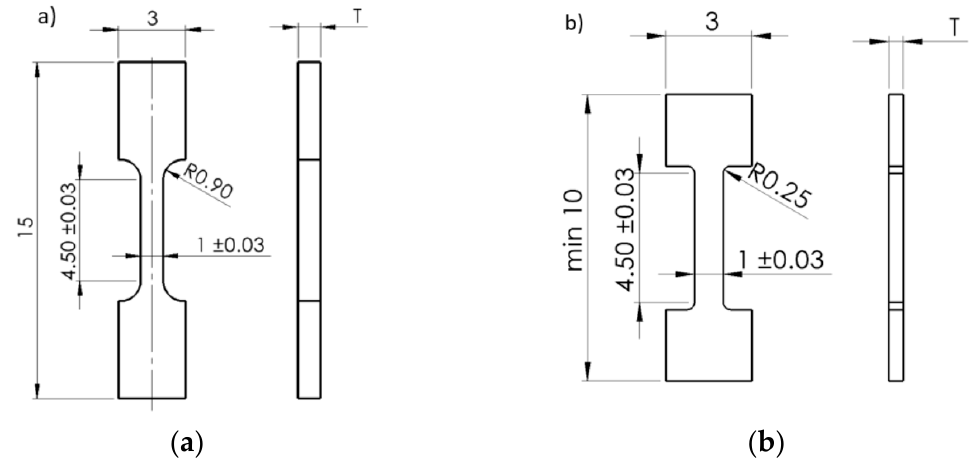
Figure 11. Geometries in millimeter of miniaturized tensile test samples (UT) in machined state applied in order to investigate the tensile properties of DED-processed honeycomb structures along ( a ) ZXY direction and ( b ) YZX direction designed using SolidWorks software.